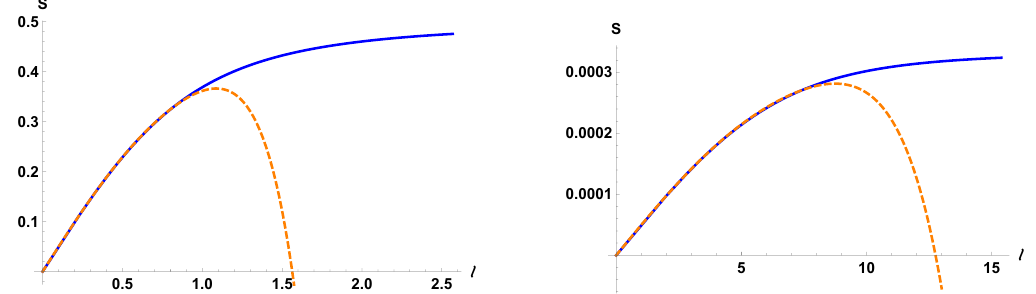
Figure 8 . HEE as a function of ‘ for different values of the cutoff: Left ) r c = 1 and d e = 3 Right ) r c = 10 and d e = 4 . The orange dashed curves are based on the perturbative solution in eq. (3.27) which is valid for very small entangling regions, i.e. l (cid:28) r results based on eq.